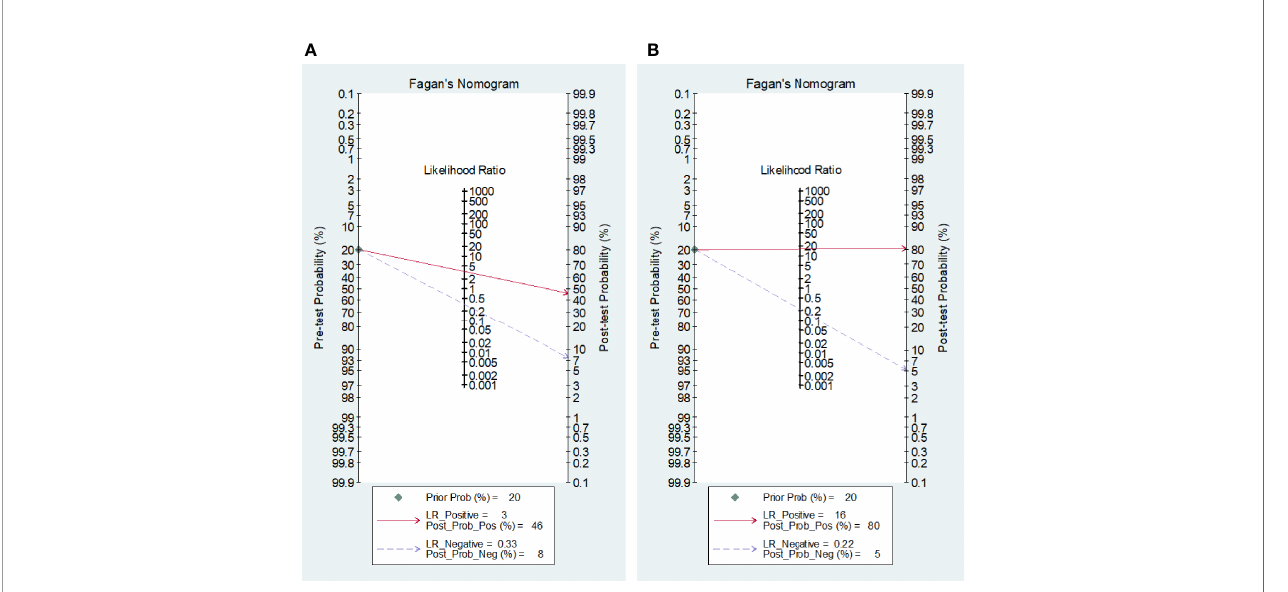
FIGURE 5 | Post-test probabilities of tuberculosis for blood (A) and CSF IGRA (B) .